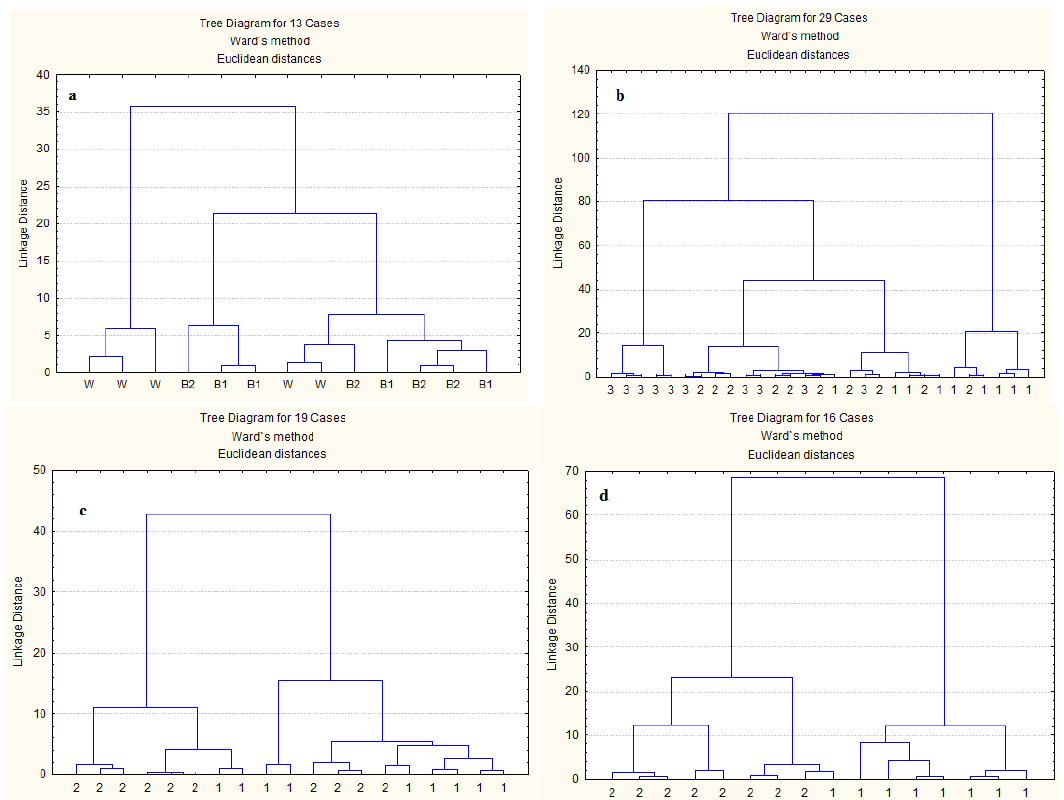
Figure 2. Cluster analysis of protein molecular spectra: ( a ) Wheat DDGS (W), BDDGS1 (B1; 30% corn and 70% wheat) and BDDGS2 (B2, 50% corn and 50% wheat); ( b ) Three batches within wheat DDGS; ( c ) Two batches within BDDGS1; and ( d ) Two batches within